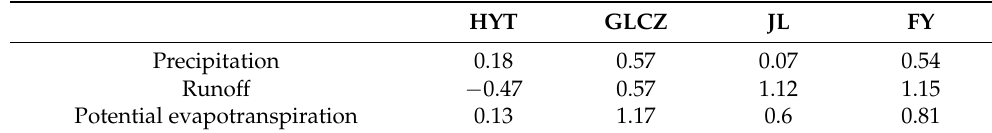
Table 1. Z-values for M–K trend test of precipitation, runoff, and potential evapotranspiration from 1989–2018.